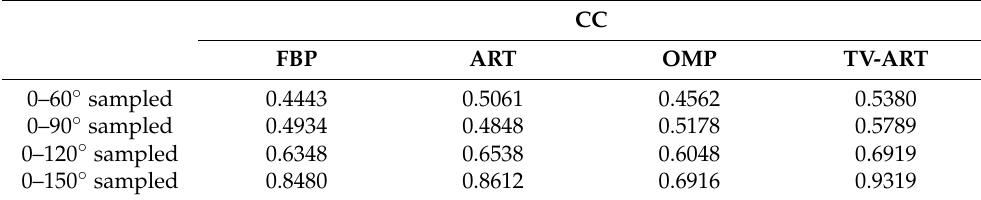
Figure 9. Near-field experimental imaging results under limited view of projections ( Far left ) iRadon; ( Left ) FBP; ( Middle ) ART; ( Right ) sparse ART with OMP; ( Far right ) TV sparse reconstruction with ART. ( a ) 0 – 60° sampled data (a1:a5); ( b ) 0 – 90° sampled data (b1:b5); ( c ) 0 – 120° sampled data (c1:c5); ( d ) 0 – 150° sampled data (d1:d5). Table 3. CC values of different algorithms with incomplete views of